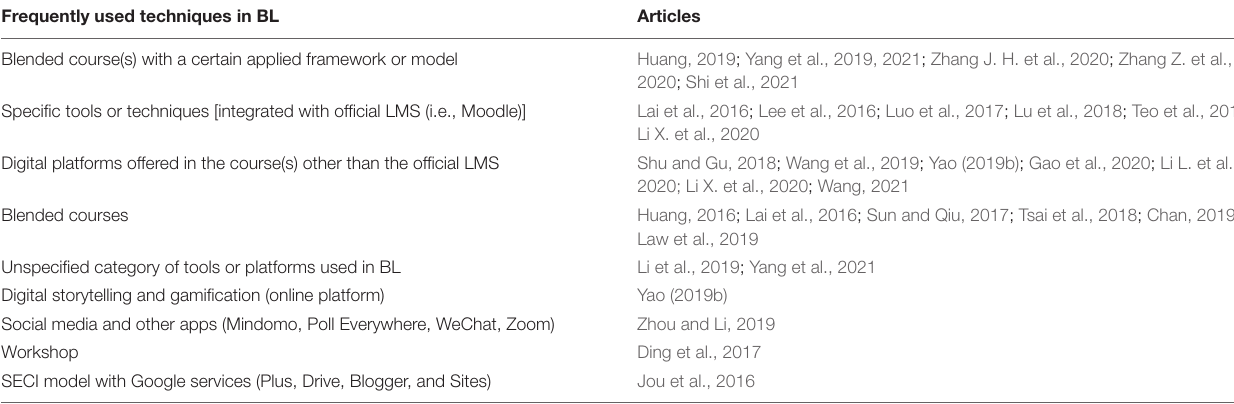
TABLE 4 | Frequently applied blended learning (BL) techniques and methods in Chinese higher education.